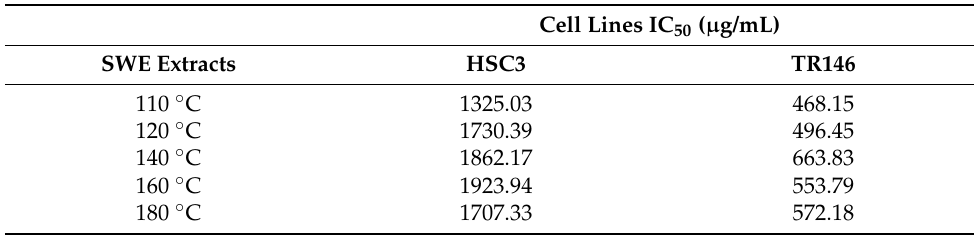
Table 5. IC 50 values of oral model cellular lines treated with C. sativa shells SWE extracts, measured by MTT assay. Values are expressed as mean ( n = 3). IC 50 = In vitro concentration required to decrease cell viability by 50%.